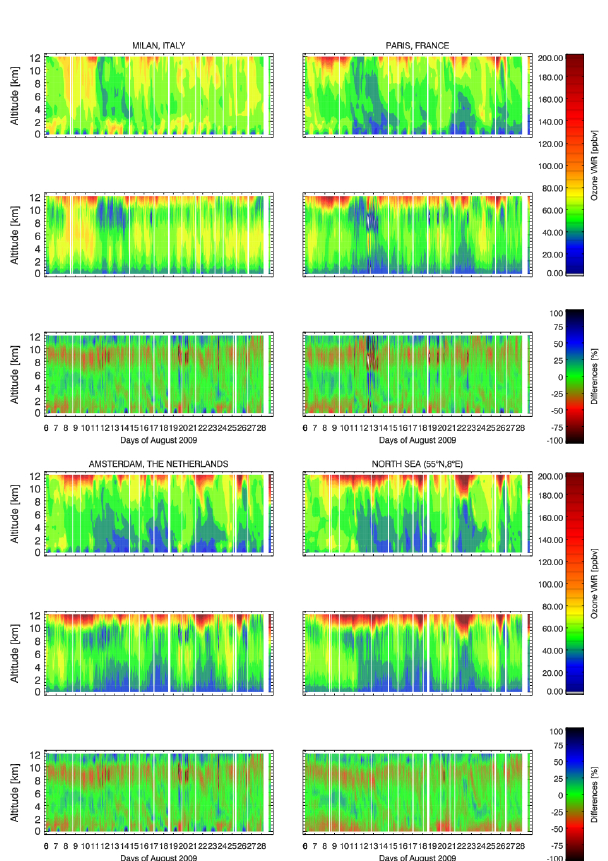
Fig. 10. Hovmöller diagrams showing the MOCAGE pseudo-reality (lines 1 and 4), MAGEAQ-TIR pseudo-observations (lines 2 and 5) and the percent differences (lines 3 and 6) for the tropospheric ozone concentration profiles over Milan, Paris, Amsterdam, the ma- rine location west of Norway’s coast, for the whole time period of our